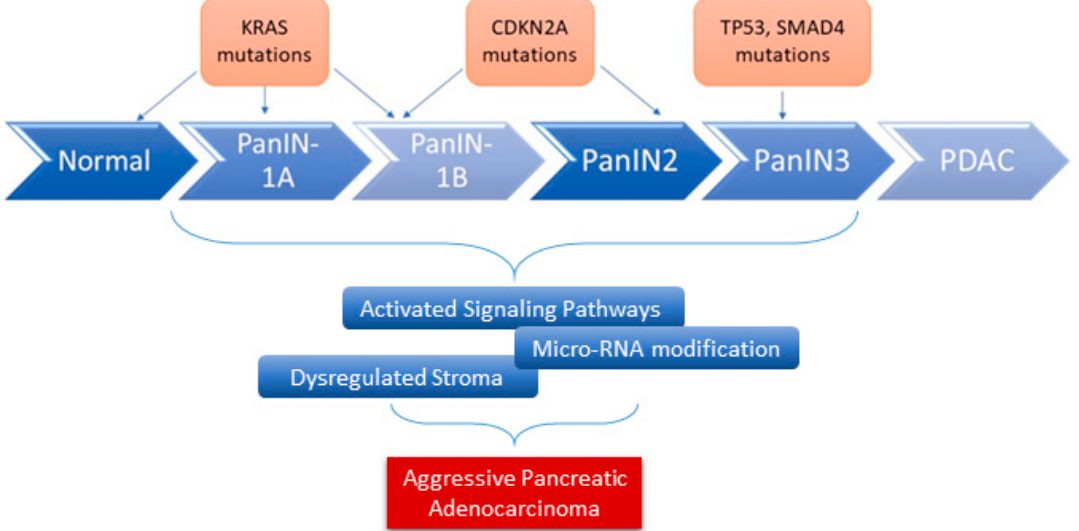
Figure 1. The role of genes and microRNAs in the progression of PDAC. Alterations in various key genes contribute to the progression of PDAC (overexpression, loss of function mutation, and inactivation). Many other factors have been shown to serve as fuel for the development of aggressive PDAC, including microRNAs dysregulation.